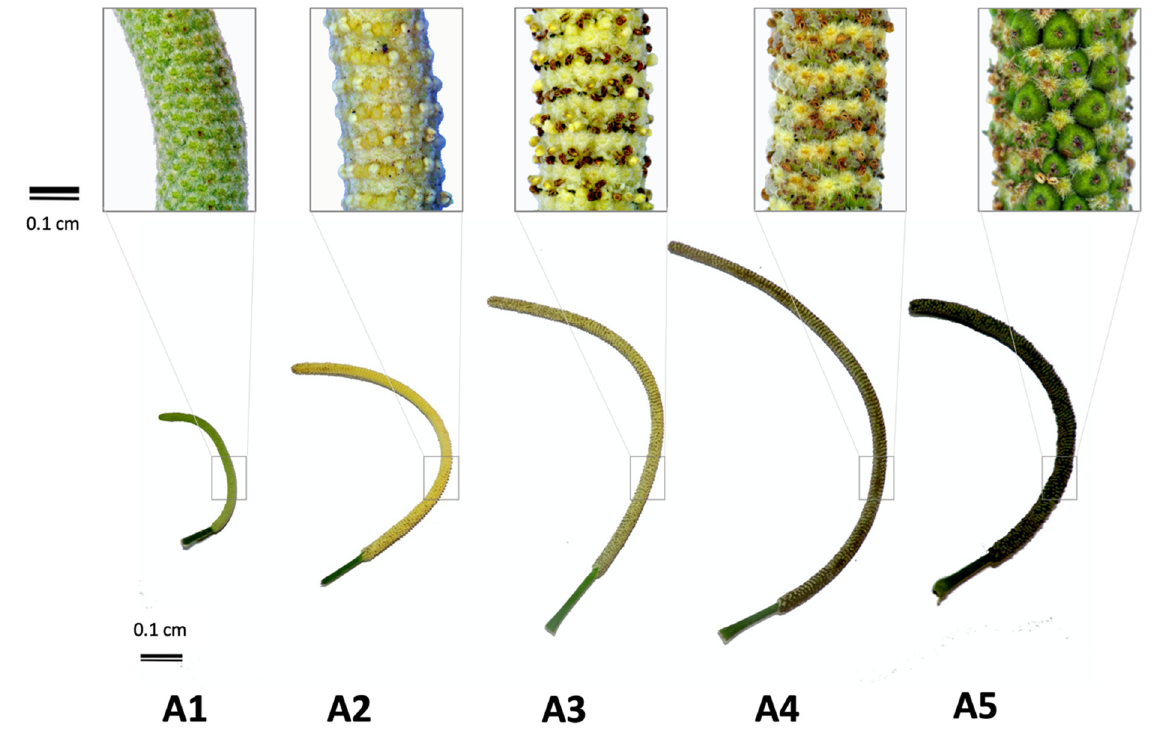
Figure 6. Stages of floral development of Piper mollicomum Kunth from the beginning of its formation (A1) to maturity (A5). A1—Inflorescence stage 1; A2—Inflorescence stage 2; A3—Inflorescence stage 3; A4—Inflorescence stage 4; A5—Inflorescence stage 5. For stage A1 to A5 description.